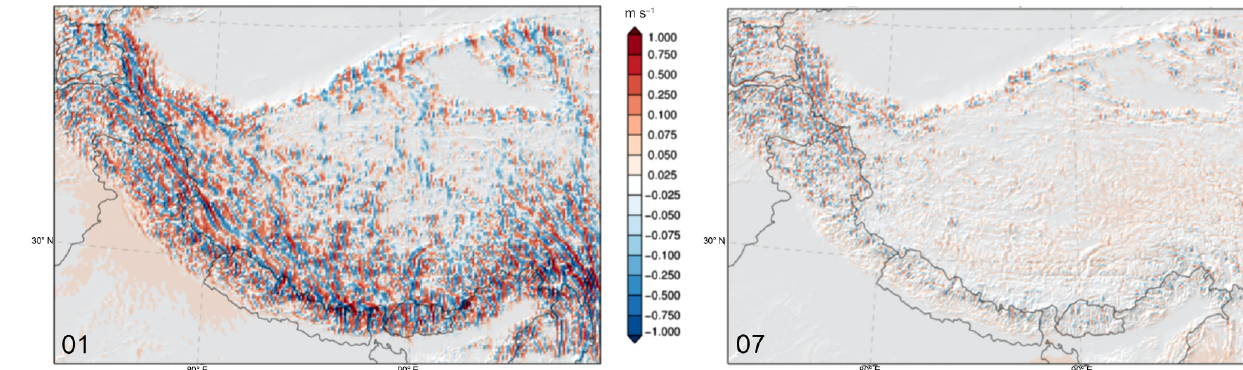
Figure 6. Mean vertical wind speed at 300hPa for January (01) and July (07).